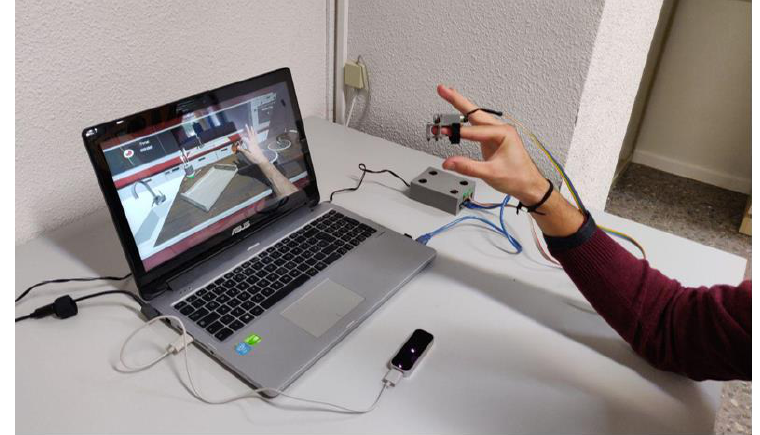
Figure 6. Example of a healthy trial with the thimble placed on the right hand.